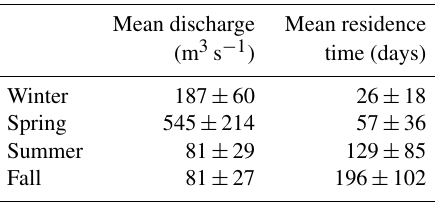
Note: data are based on discharge and box model results for the period from April 2010 to March